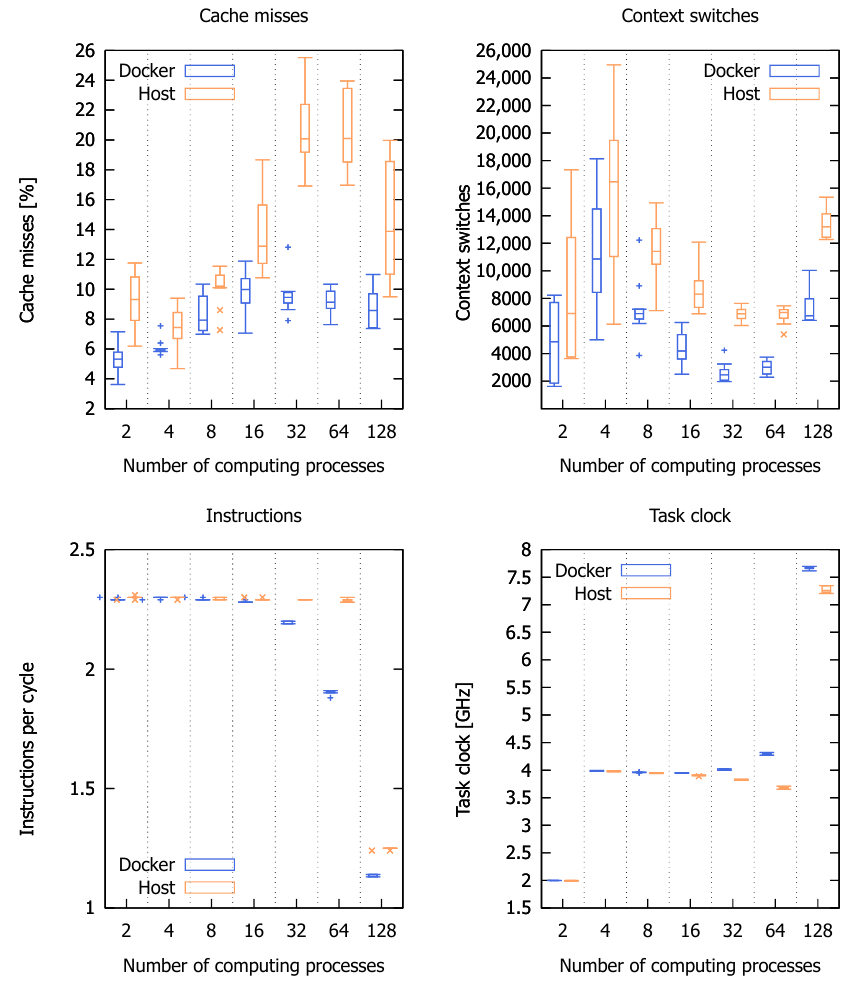
Figure 15. Hardware counters for DAC program with -O2 compilation parameter; boxplot nota- tion: medians, Q1 and Q3, max(Q1 − 1.5IQR, minimum) and min(Q3+1.5IQR, maximum) as well as potential outliers (+ for Docker, x for